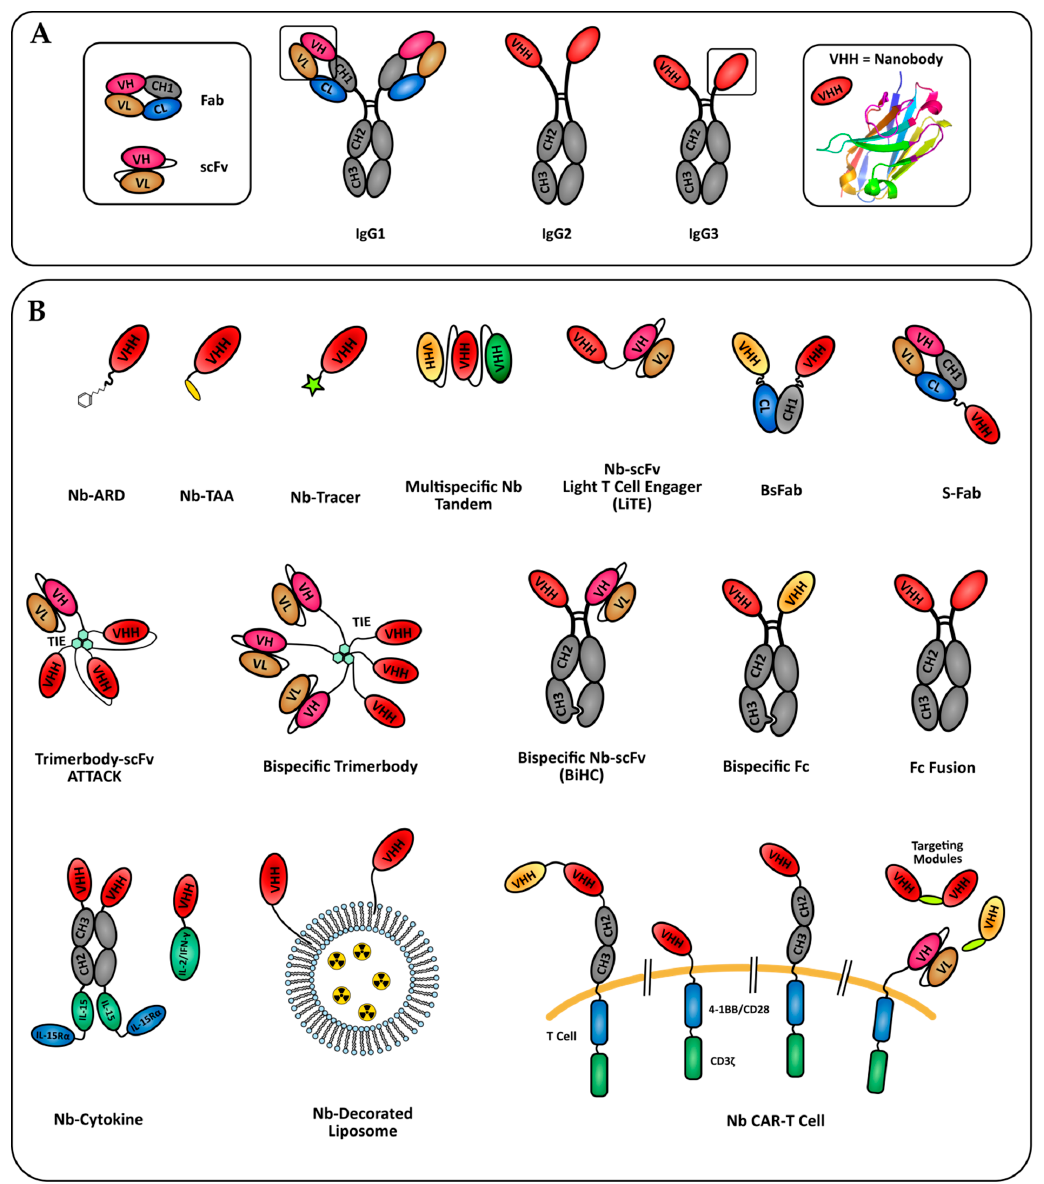
Figure 1. Nanobody-based formats in development for tumor immunotherapy and imaging. ( A ) Camelids specificity domains derived of conventional IgG1 or HcAbs (IgG2 and IgG3). The nanobody crystal structure shown is pdb entry 6GZP. ( B ) Formats of nanobody engineered molecules discussed in this review. Nb: nanobody; ARD: antigen recognition domain; TAA: tumor associated antigen.